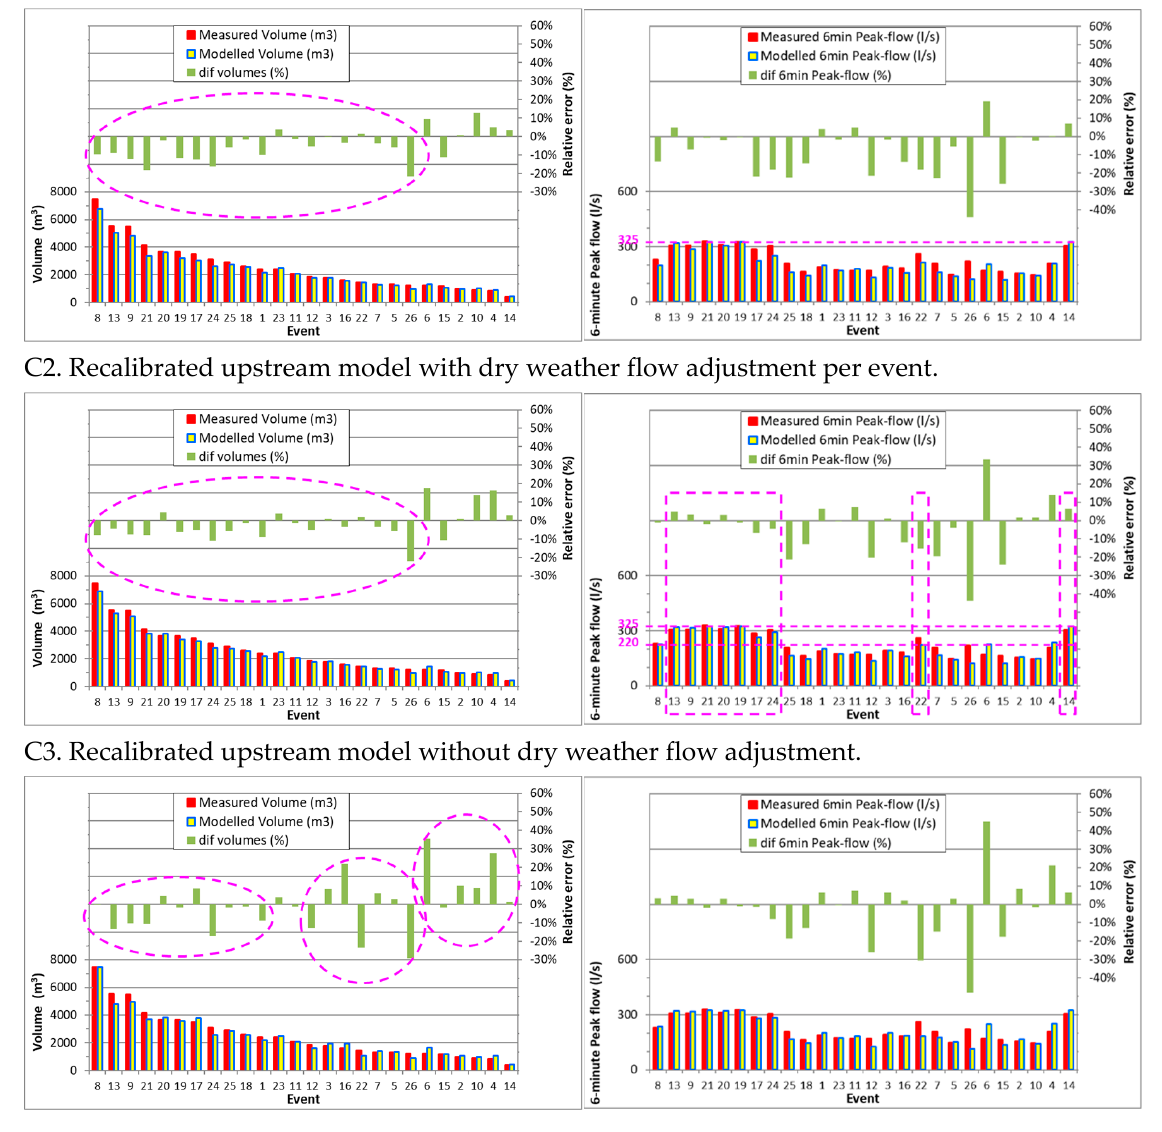
Figure 5. Graphical results for volume and 6-min peak flow in monitoring section B1-I.